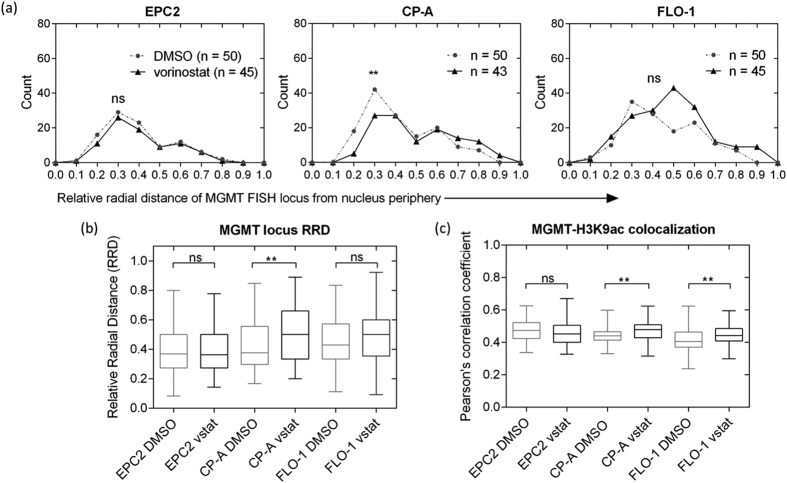
Increased MGMT expression after vorinostat exposure is accompanied by differential repositioning of gene locus and H3K9ac-colocalization between normal and abnormal esophageal epithelial cells.(a) Histograms illustrate the trends in nuclear positioning of the MGMT locus in DMSO (dotted gray)- and vorinostat (black)-treated normal EPC2, metaplastic CP-A, and malignant FLO-1 cells. Nuclear position was computed using the relative radial distance (RRD) metric (0 = periphery, 1 = center). Upon vorinostat exposure, the MGMT locus moved towards the nuclear interior in CP-A, but not in EPC2 or FLO-1 cells. P-value is indicated by *: ns = not significant (p > 0.05), **p < 0.01. Exposure to vorinostat in FLO-1 altered the distribution of RRDs such that they became normally distributed (A = 0.5933, p-value = 0.1198). Similar results were not seen in CP-A. (b) Box plots reflect the extent of heterogeneity in nuclear position of the MGMT locus in each cell type before and after vorinostat treatment. Treated FLO-1 cell nuclei exhibited the greatest heterogeneity in nuclear position of MGMT compared to CP-A and EPC2 cells. (c) Box plots show a significantly higher (p < 0.01) colocalization of MGMT with H3K9ac-marked euchromatin domains in drug-treated CP-A and FLO-1 cells and no change in EPC2 cells. Co-localization was assessed through Pearson’s correlation of the pixel intensities of MGMT FISH and H3K9ac staining. Frequency distributions were analyzed using the Kolmogorov-Smirnoff (KS) nonparametric test.